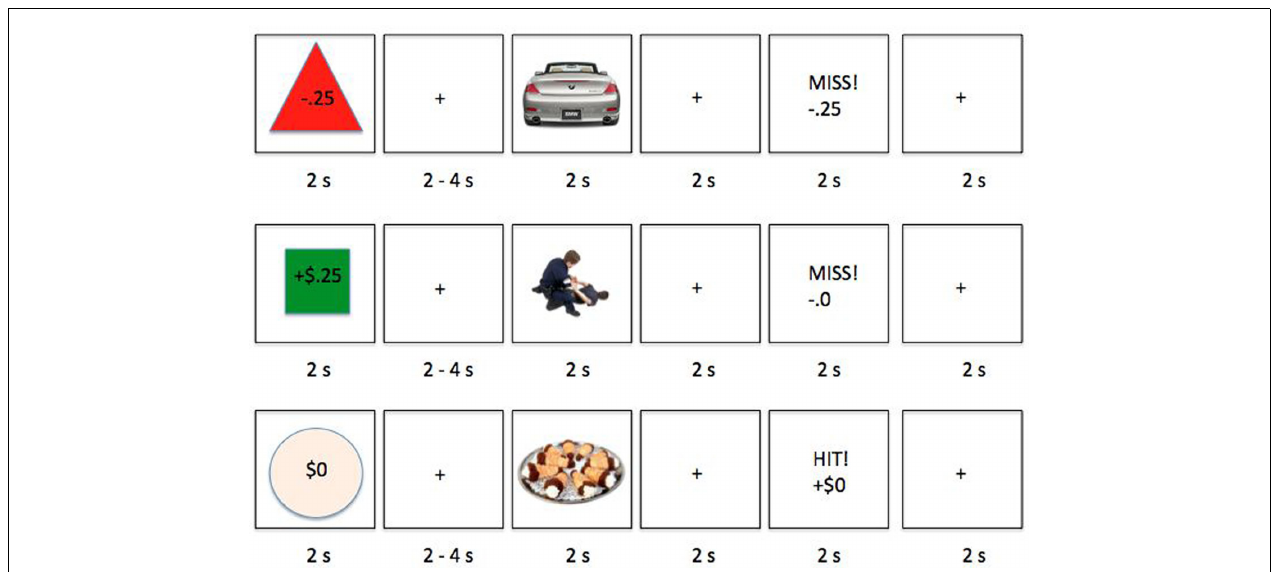
FIGURE 1 | Examples of experiment trials, with a loss-anticipation trial in the first row, gain anticipation in the second row and no anticipated monetary outcome in the third row. Participants were asked to hit a key as quickly as they could when they saw a picture, then they received feedback about whether they responded quickly